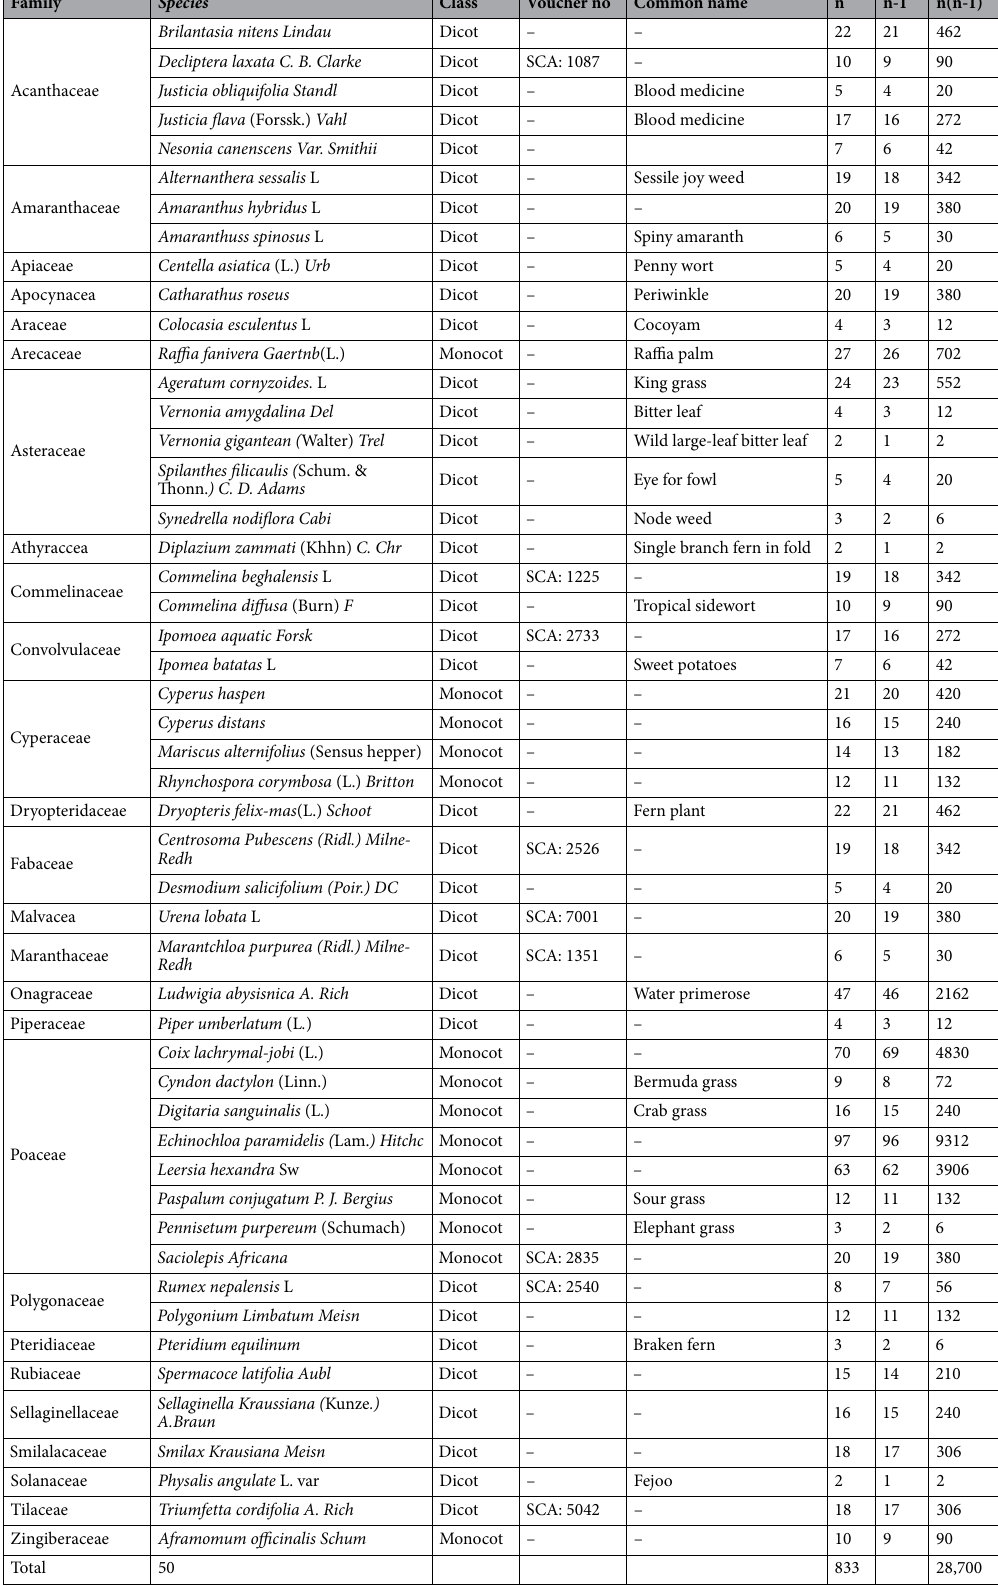
Table 5. Simpson index of diversity from vegetation samples at Rural site (Mbelewa) in the Bamenda Municipality. SCA = Southern Cameroon (code for the Limbe Botanic Gaderns), D = 0.041411, Simpson Index =